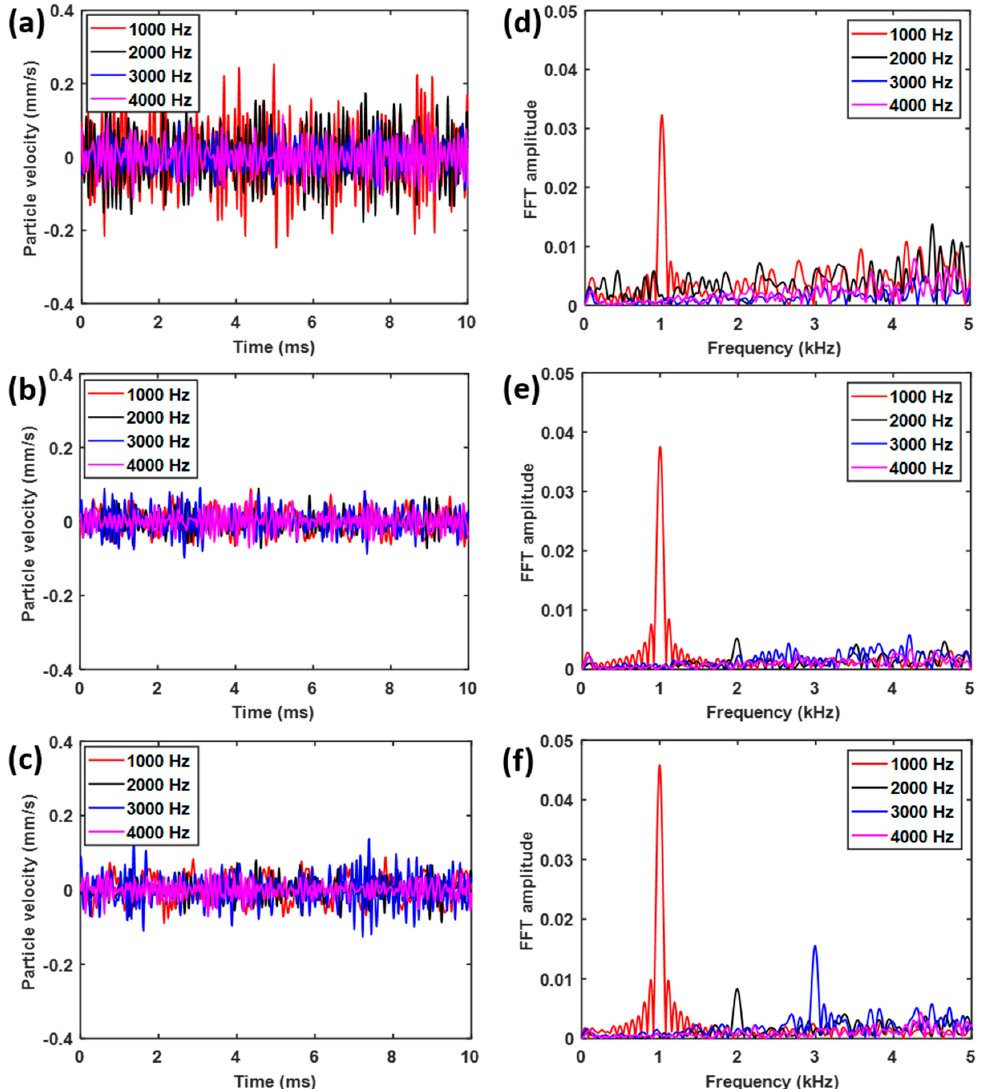
Figure 6. Particle velocities, which are proportional to the local pressure, in the temporal domain and their frequency spectrum, ( a )–( c ) particle velocities at the hollow tube corresponding to locations of the 37th, 17th and 7th cylinders, and ( d )–( f ) their Fourier spectrum correspondingly.